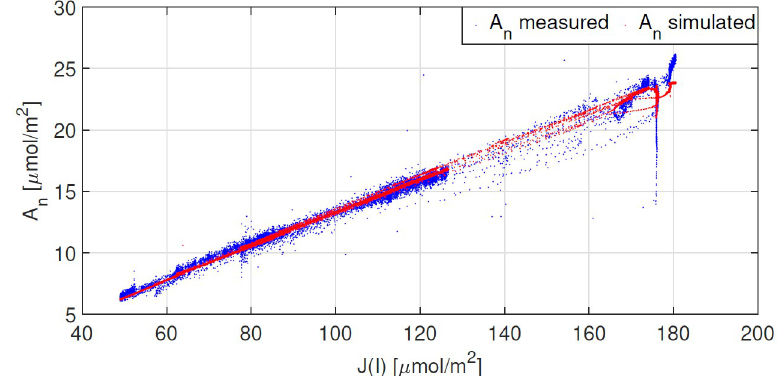
Fig 6. Results obtained after parameter estimation. The correlation between A n and the electron transport rate (J(I (t)) is shown for both measured and simulated data sets.